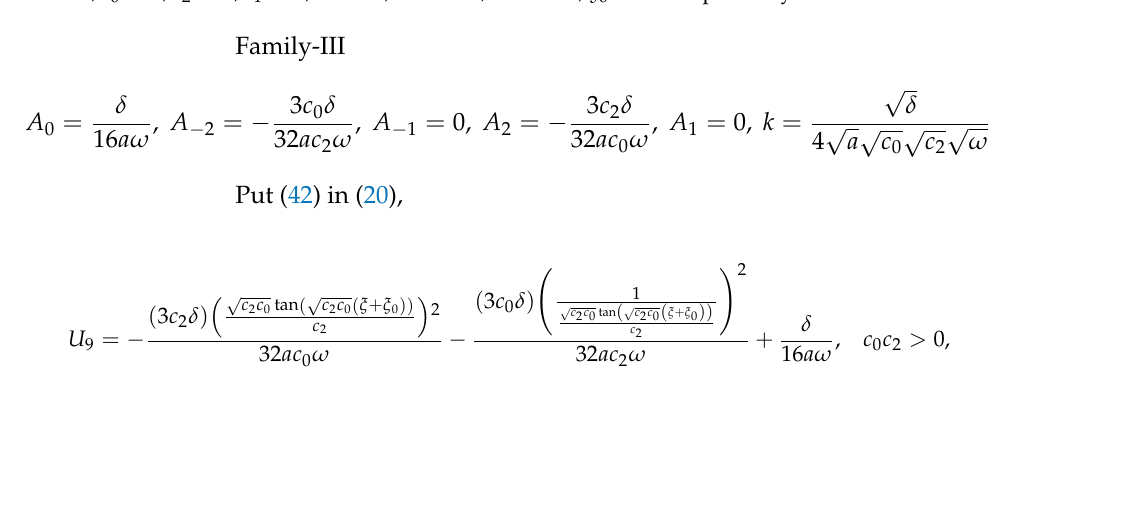
Figure 2. The profile of solutions U 5 ( a , b ) and V 5 ( c , d ) with α = 1, c 0 = 0.2, c 2 = 1, c 1 = 2, δ = − 0.2, a = 0.01, ω = 0.5, ξ 0 = 0.5 and α = 1, c 0 = 2, c 2 = 1, c 1 = 2, δ = 0.2, a = 0.01, ω = 0.05, ξ 0 = 0.5